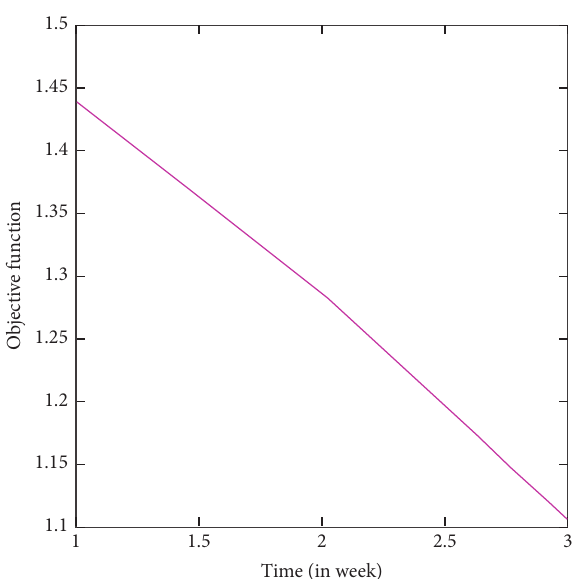
Figure 7: Change in objective function with time.